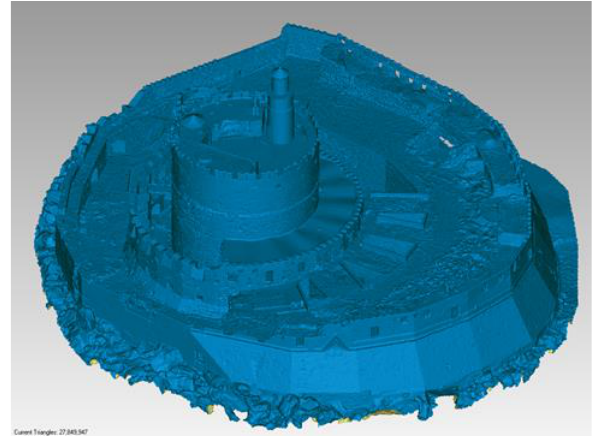
Figure 7 . The integrated 3D model of the Saint Nikolaos Fort and lighthouse.